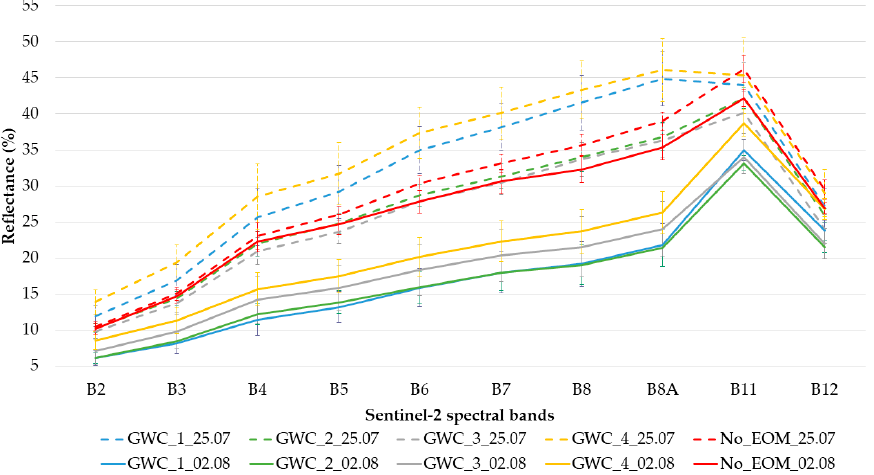
Figure 3. Mean reflectance spectra of reference fields before (25 July) and after (2 August) green waste compost spreading of end of July 2018.